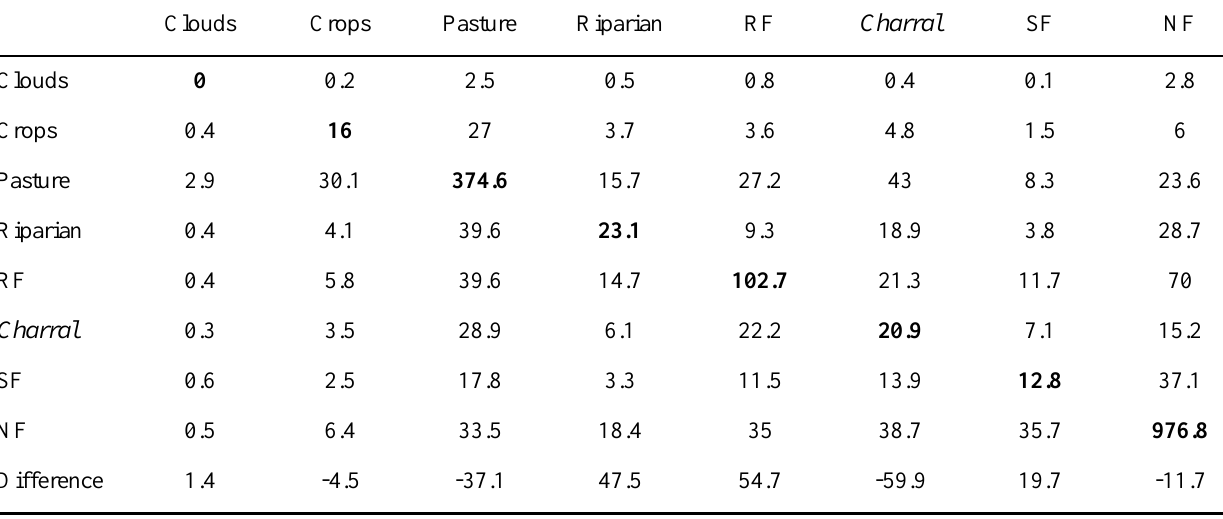
Table A1-2 . Land-cover changes from 1996 to 2001. Clouds Crops Pasture